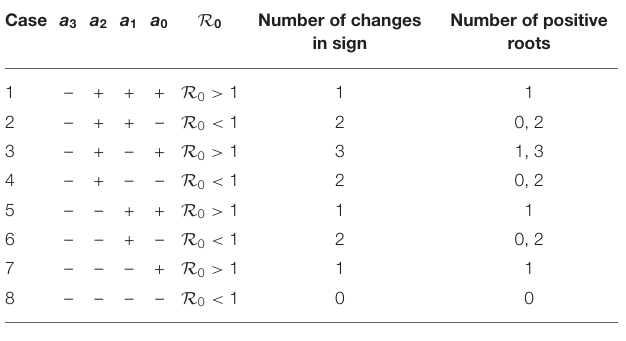
TABLE 1 | Number of positive roots of Equation (12). Case a 3 a 2 a 1 a